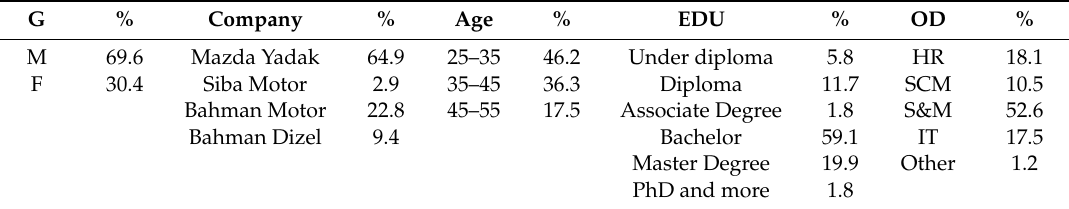
Table 2. Demographic information of respondents.